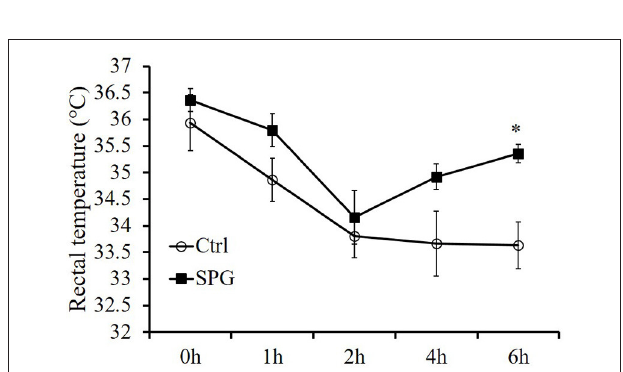
FIGURE 8 | Supaglutide-treated mice were more tolerant with cold exposure. Mice after 4 weeks’ treatment were starved for 6h, followed by being placed for 6h in a room with a temperature of 4–8 ◦ C. Body temperature was recorded once per hour with a rectal probe connected to a digital thermometer and the significant difference is indicated for control vs. SPG by two-way RM ANOVA. All values are means ± SE ( n = 5 for each group). * p <